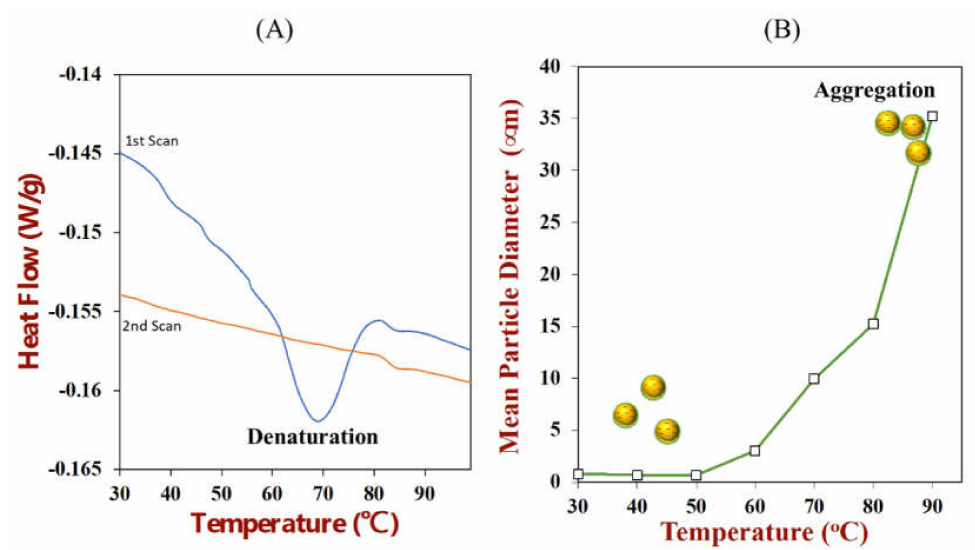
Figure 11. ( A ) Differential scanning calorimetry analysis shows that Rubisco protein is irreversibly thermally denatured when heated from between 65 to 75 ◦ C. ( B ) The droplets in Rubisco-stabilized emulsions aggregate when they are heated above their thermal denaturation temperature because of an increase in surface hydrophobicity when the proteins unfold (data from our